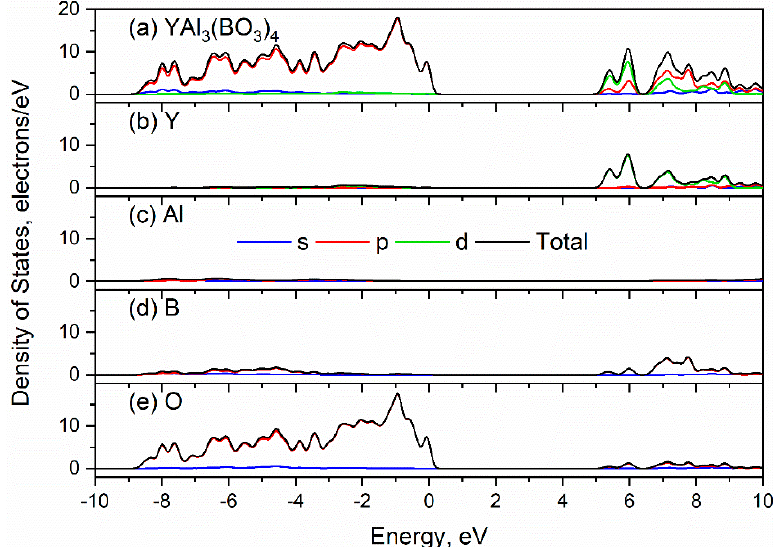
Figure 4. Total ( a ) and partial density of states ( b ), ( c ), ( d ), ( e ) of YAl 3 (BO 3 ) 4.